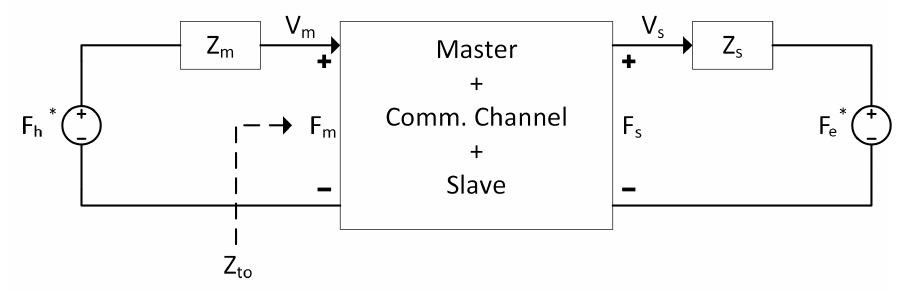
Figure 2. Equivalent circuit diagram of a bilateral teleoperated